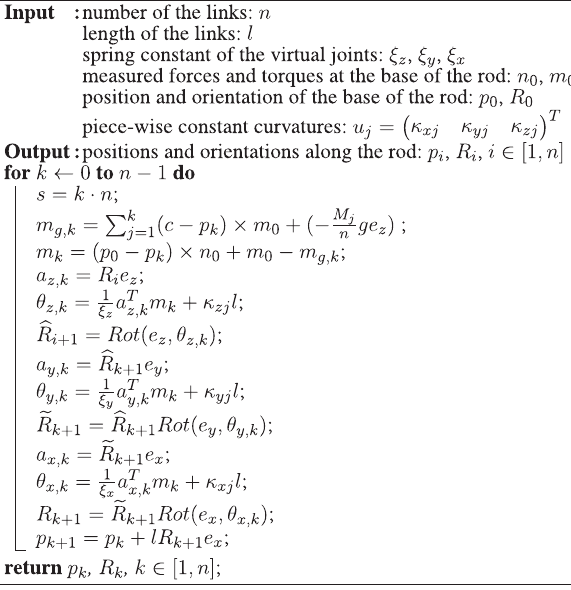
Algorithm 1: Shape estimation algorithm for each segement of a CTR with precurved